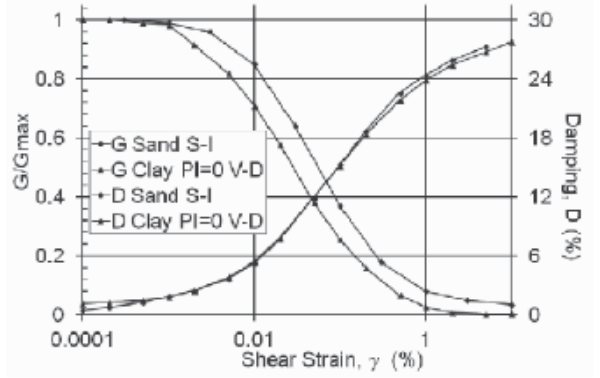
Figure 15. Stiffness degradation and damping increase with shear strain for sand and